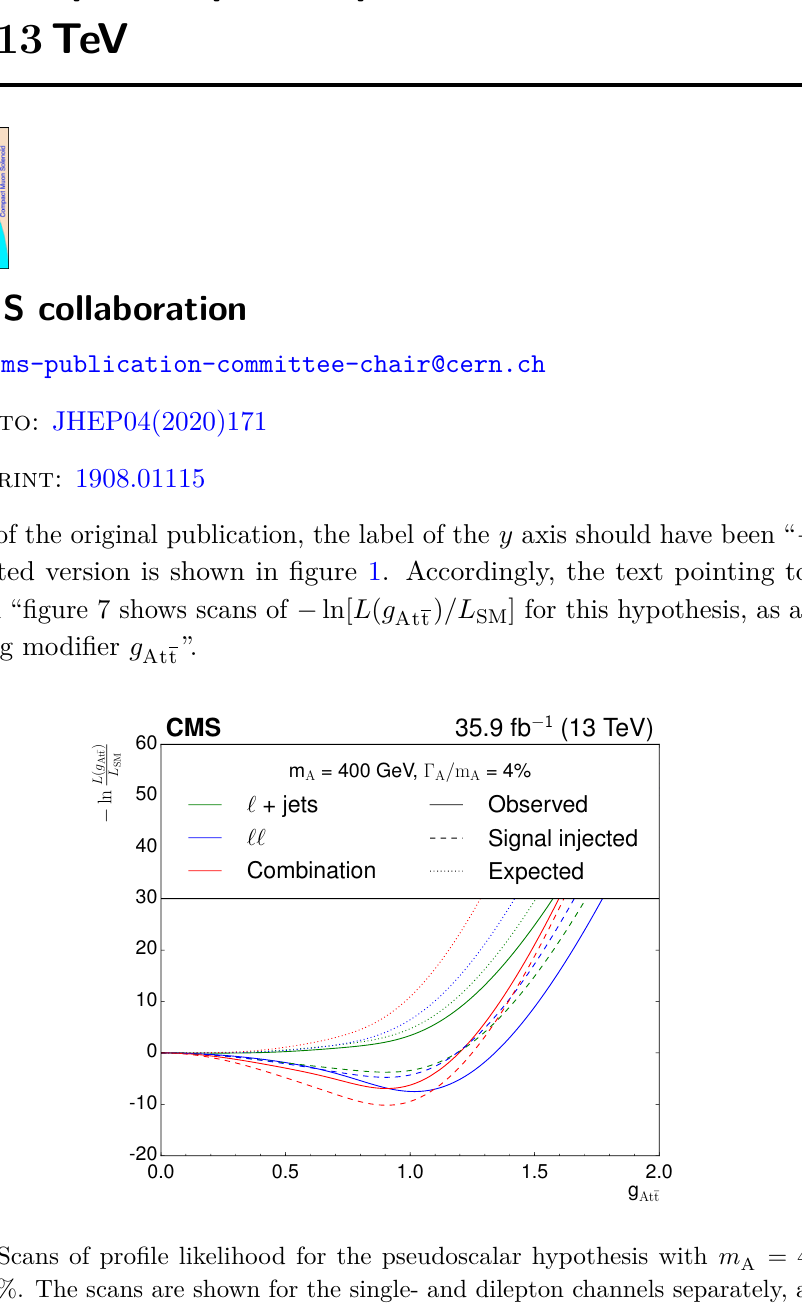
Figure 1 . Scans of profile likelihood for the pseudoscalar hypothesis with m Γ = 4% . The scans are shown for the single- and dilepton channels separately, as well as for /m A A the